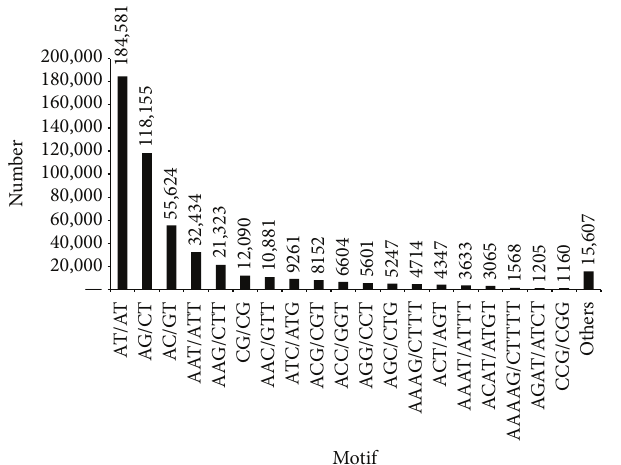
Figure 8: The number of simple sequence repeats (SSRs) discovered in the unigenes of V. mandarinia classified based on motif sequence